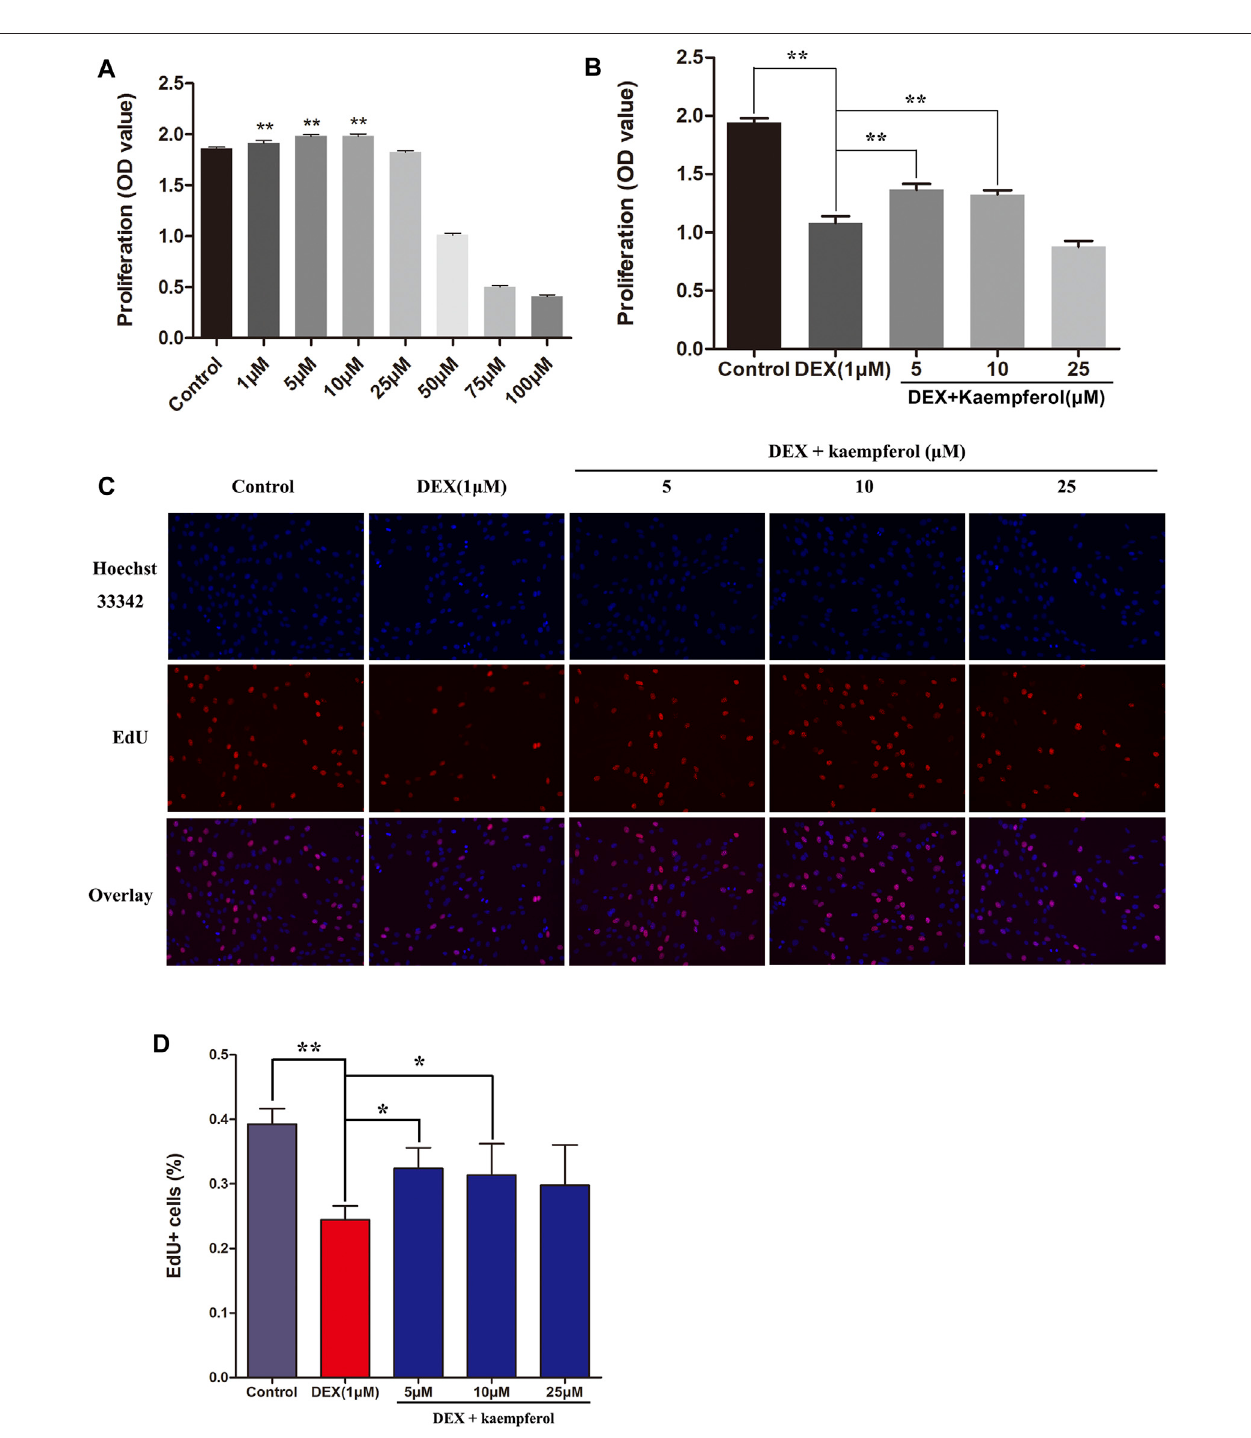
FIGURE 1 | The effect of kaempferol on cell proliferation in DEX-treated MC3T3-E1 cells. (A) Cells were co-cultured with kaempferol (1 – 100 μ M) for 3 days. (B) Cells were co-cultured with kaempferol (5, 10, and 25 μ M) and DEX (1 μ M) for 3 days. (C, D) Cells were treated for 24 h with kaempferol (5, 10, and 25 μ M) and DEX (1 μ M) and analyzed by EdU assay. * p < 0.05, ** p < 0.01.